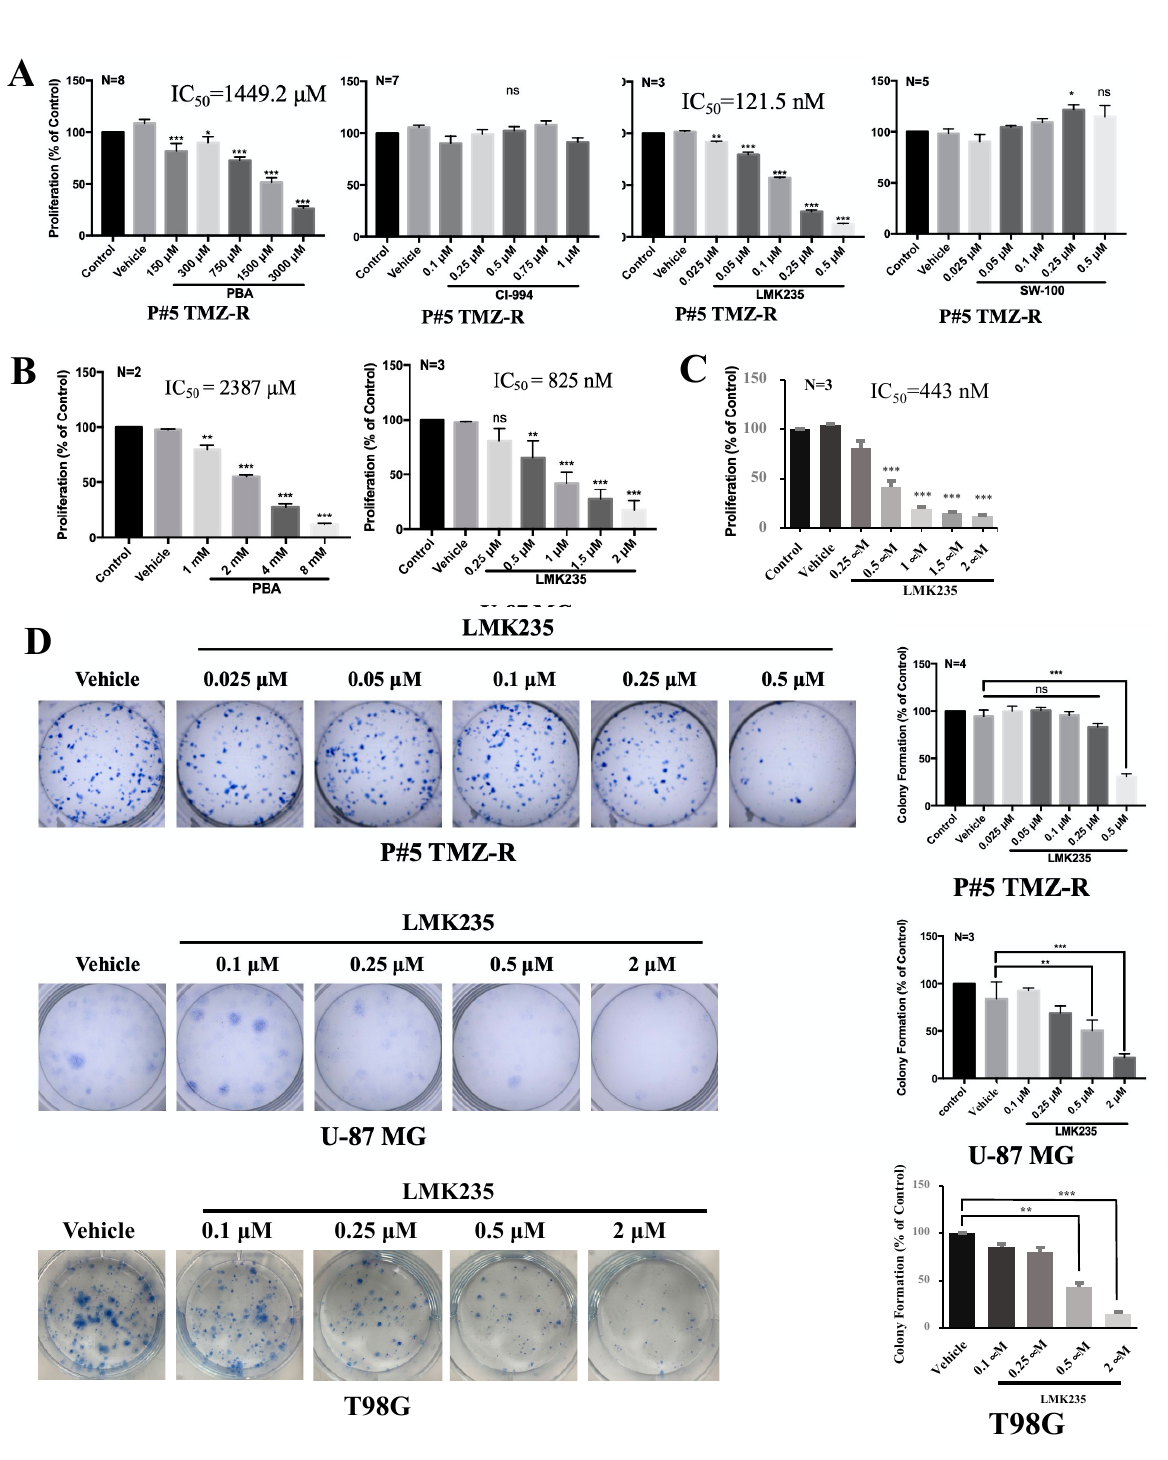
Figure 1. The antitumor effect of HDACi on GBM cells. Cells were incubated with PBA, CI-994, LMK235, or SW-100 at the indicated doses and then analyzed by cell viability assays ( A – C ) and clonogenic assays ( D ). The IC 50 values were determined by plotting the growth relative to that of the vehicle controls. The quantification of colonies was performed manually and compared to the vehicle control. All experiments were repeated at least three times. The data are expressed as the means ± S.E. of three or more independent experiments. Scale bar = 0.5 cm in ( C ). ns: no significance. * p < 0.05., ** p < 0.01, *** p < 0.001.